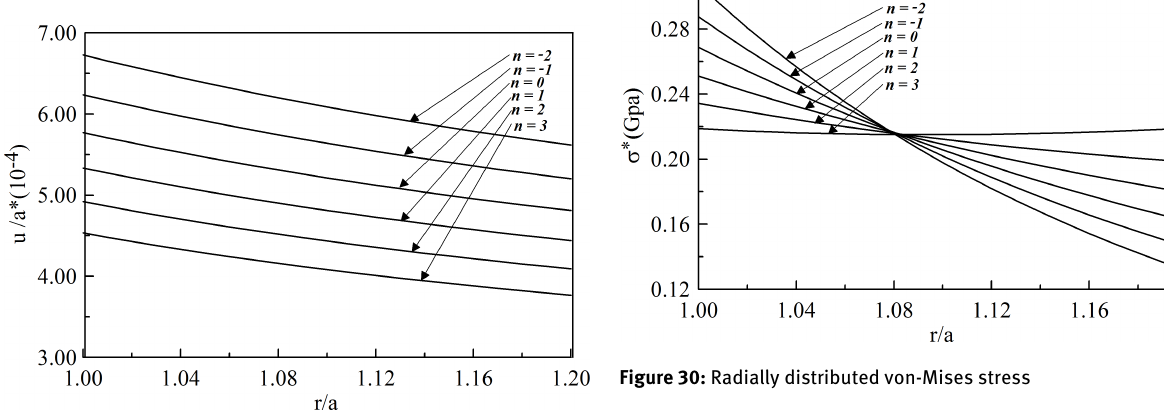
Figure 26: Radially distributed temperature